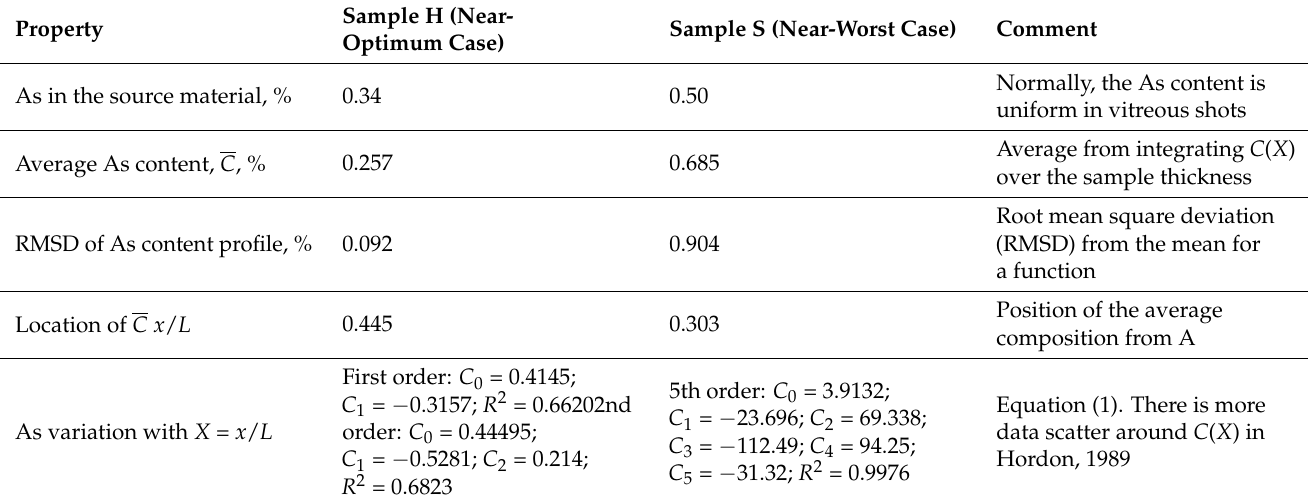
Table 1. Fractionation characteristics of a-Se films S and H in Figures 2 and